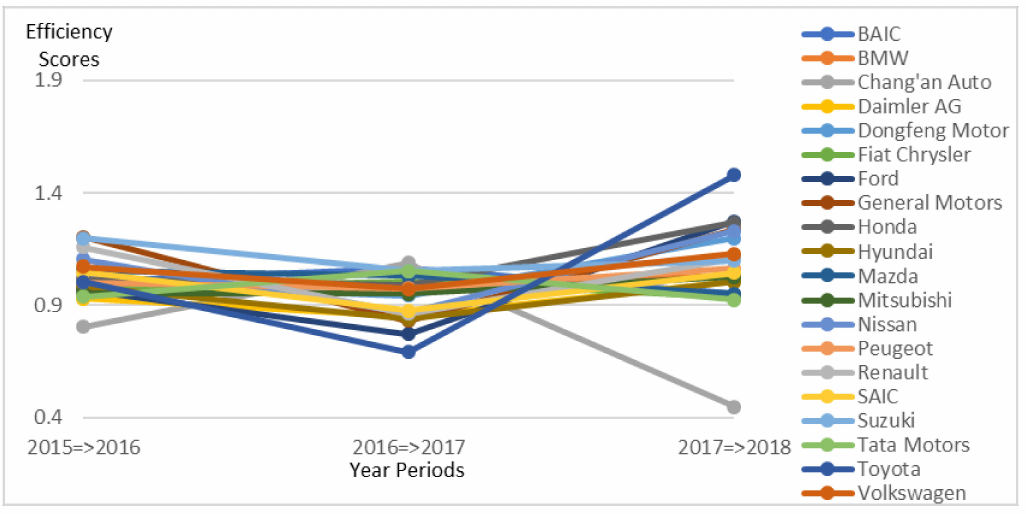
Figure 3. Technical e ffi ciency changes of each